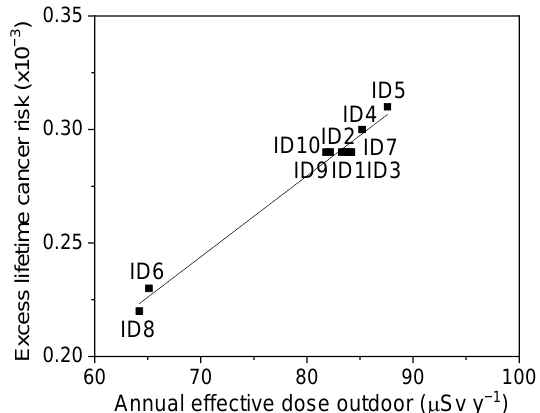
Figure 3. The linear relationship between ELCR and the annual effective dose equivalent for all the investigated sampling sites.